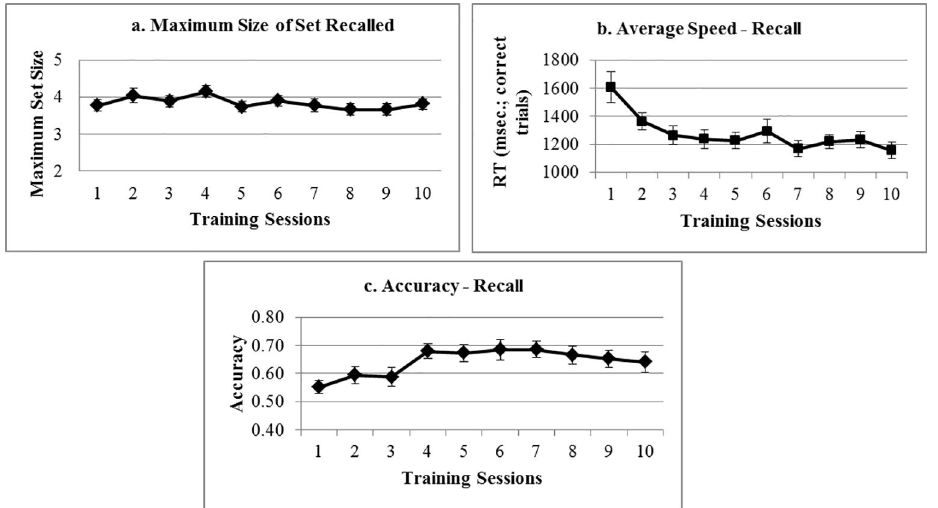
Figure 4. Training performance for the WM game: a) maximum set size recalled for each training session, b) average reaction time (RT) during the recall part of the game, c) average accuracy during the recall part of the game.